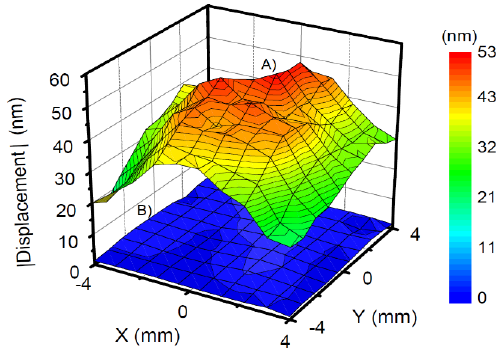
Figure 6. Maps of the absolute values of the amplitudes of motion determined with an LDV setup based on scattering. ( A ) Transverse motion, ( B ) normal motion.